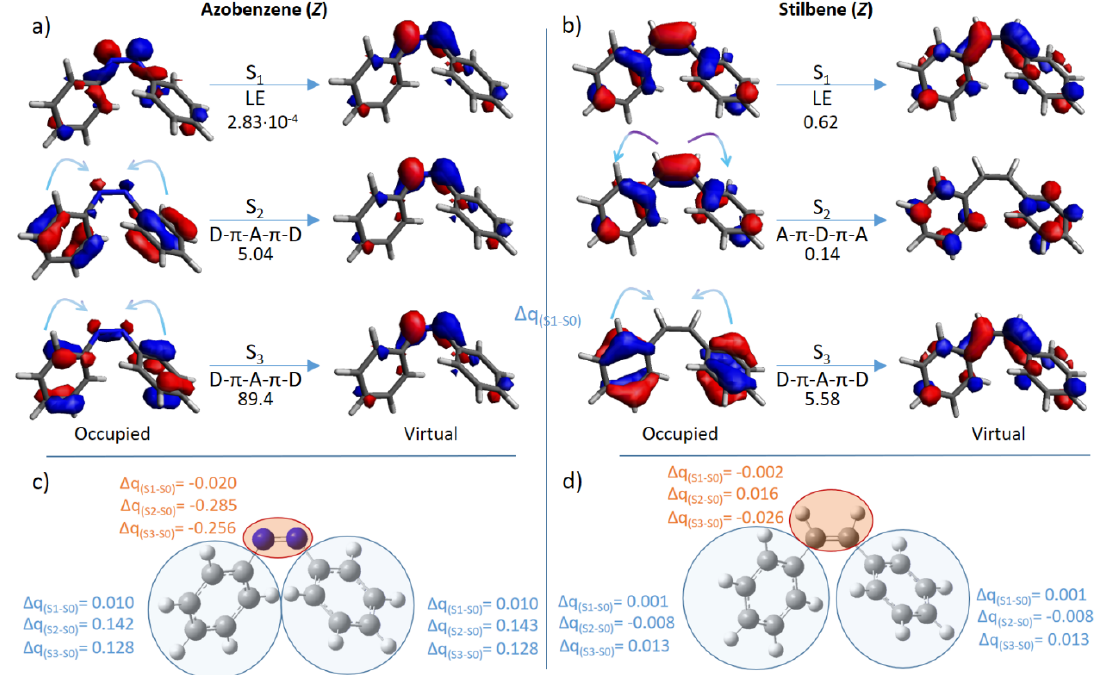
Figure 3. Molecular orbitals mainly involved in the lowest-in-energy optical transitions (S 0 → S 1,2,3 ) for the Z form of azobenzene ( a ) and stilbene ( b ). The type of electronic transfer (locally excited (LE); from the lateral moieties to the central one (D- π -A- π -D); from the middle moiety to the lateral moieties (A- π -D- π -A) and the σ TPA value in GM are given below each arrow. The partial charge transfer ( Δ q) of groups of atoms (highlighted in light blue and orange) from each excited state to S 0 , is shown for Z -azobenzene ( c ) and Z -stilbene ( d ).